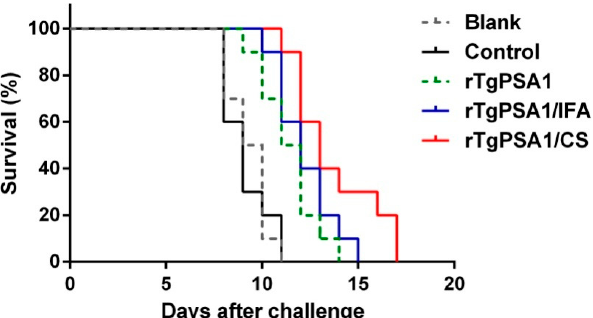
Figure 6. Mouse survival rates subsequently challenged by infection with 200 newly prepared tachyzoites ( T. gondii RH strain). Results were examined by Kaplan–Meier test and survival curves were tested by log-rank model (n = 5).